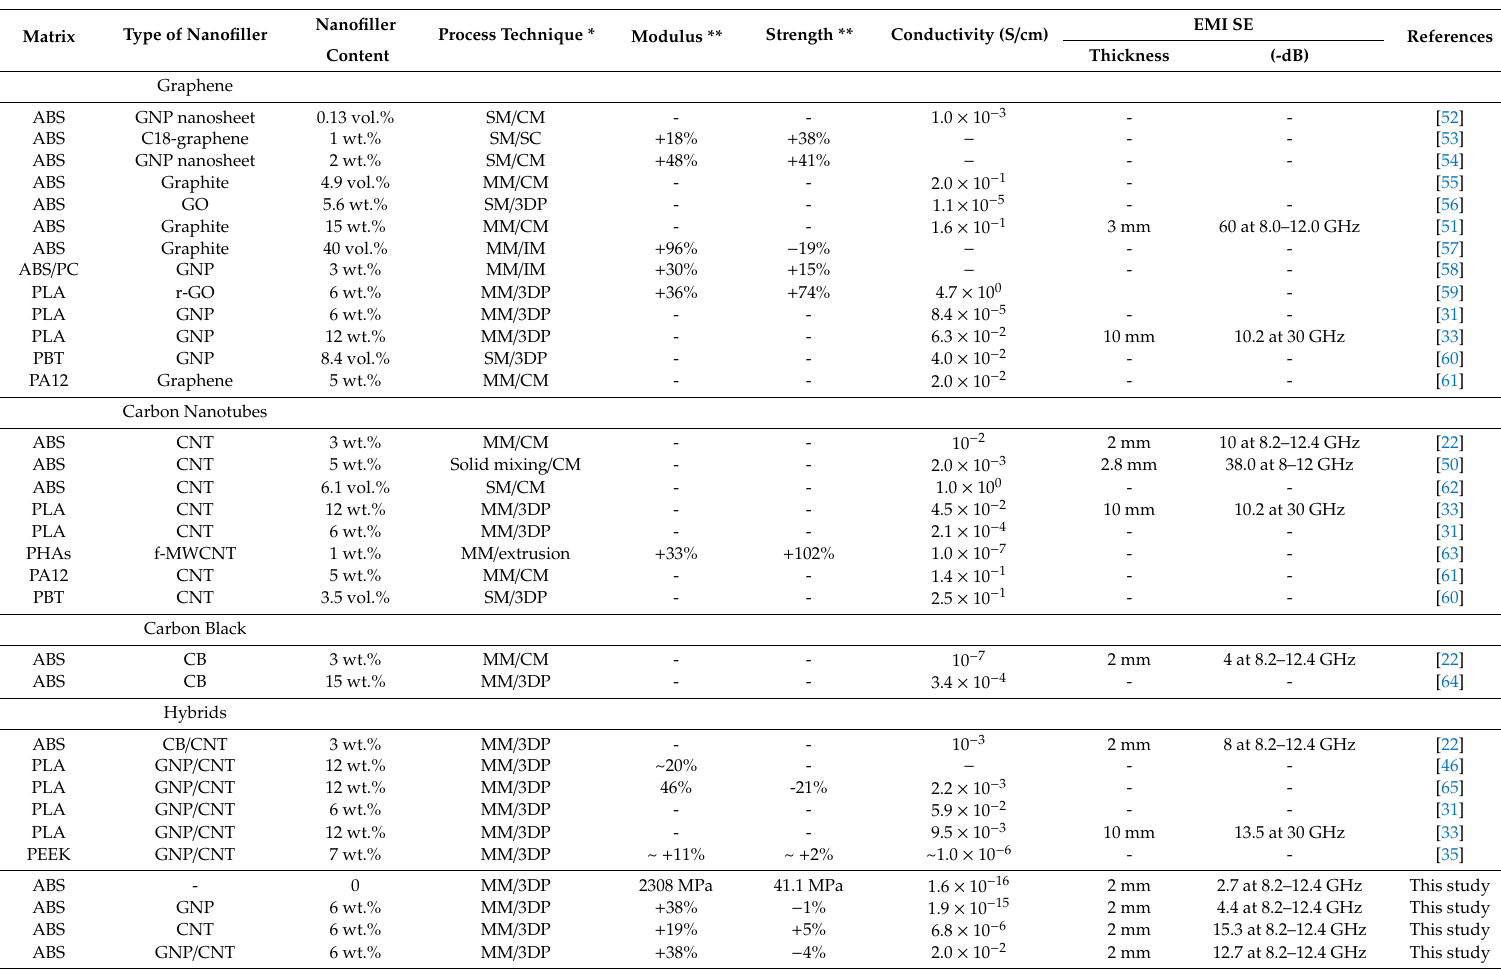
Table 3. Comparison of selected properties of ABS nanocomposites studied in this research with respect to other carbon-based engineering